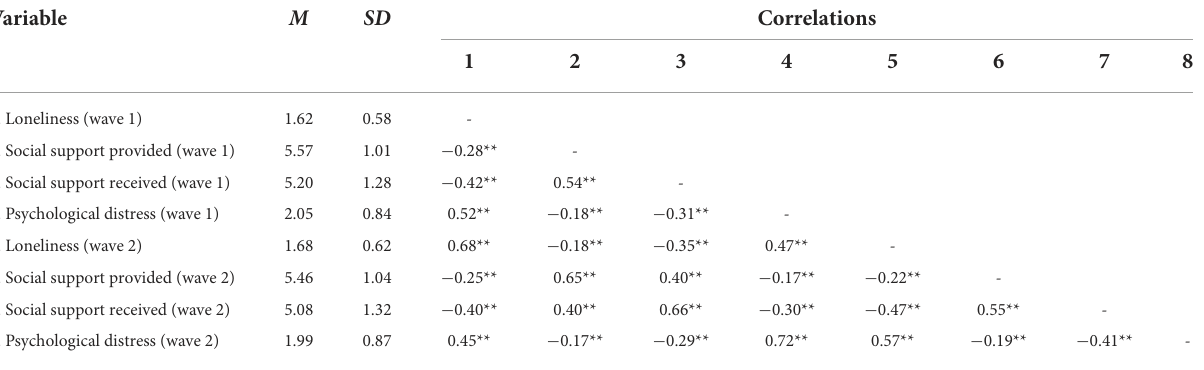
TABLE 2 Means, standard deviations, and bivariate correlations for key variables wave 1 and 2. Variable M